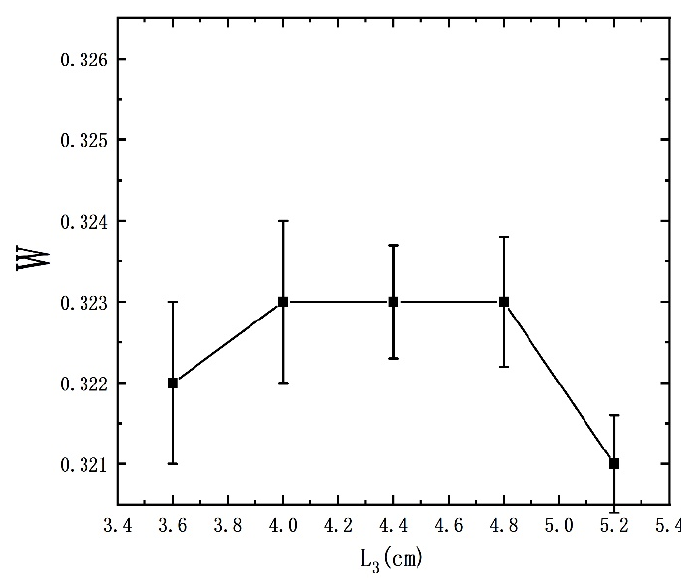
Figure 12. The transmission probability W versus L 3 .